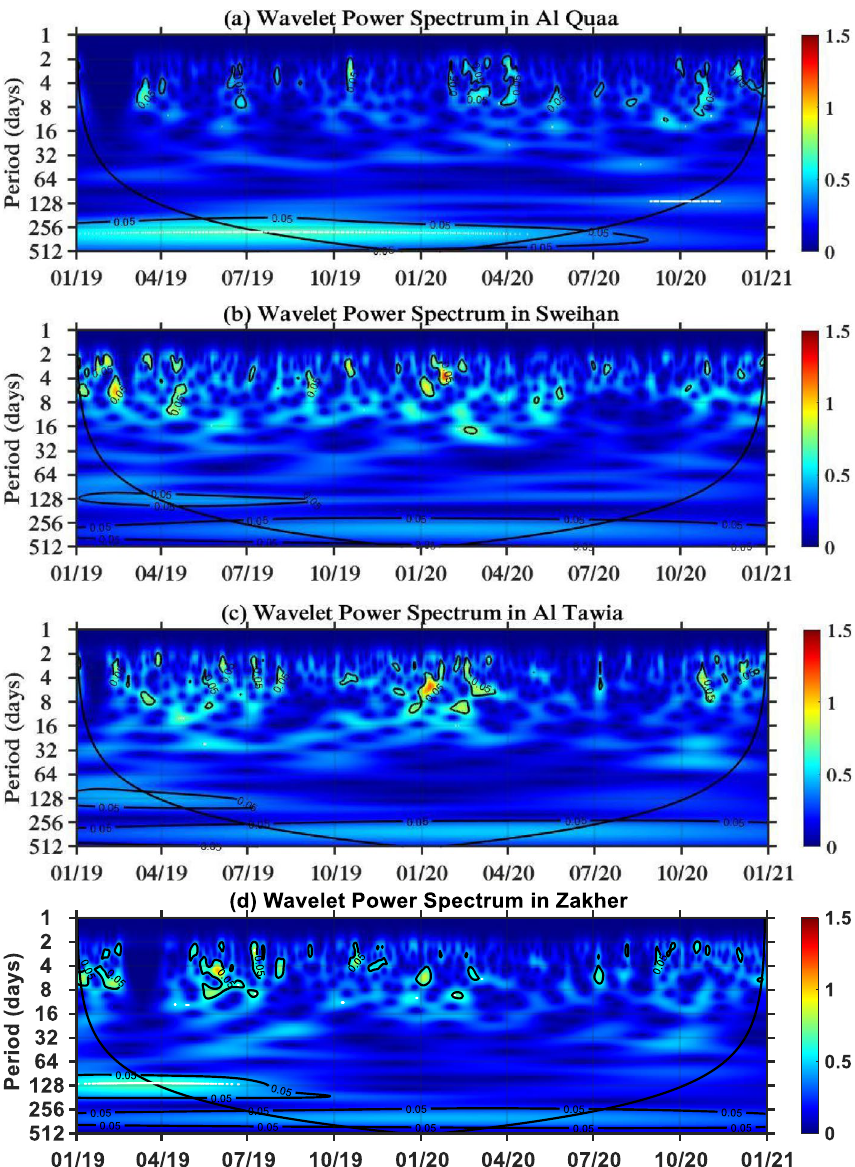
Figure 6. Wavelet power transform in the Al Ain region: ( a ) Al Quaa, ( b ) Sweihan, ( c ) Al Tawia, ( d )